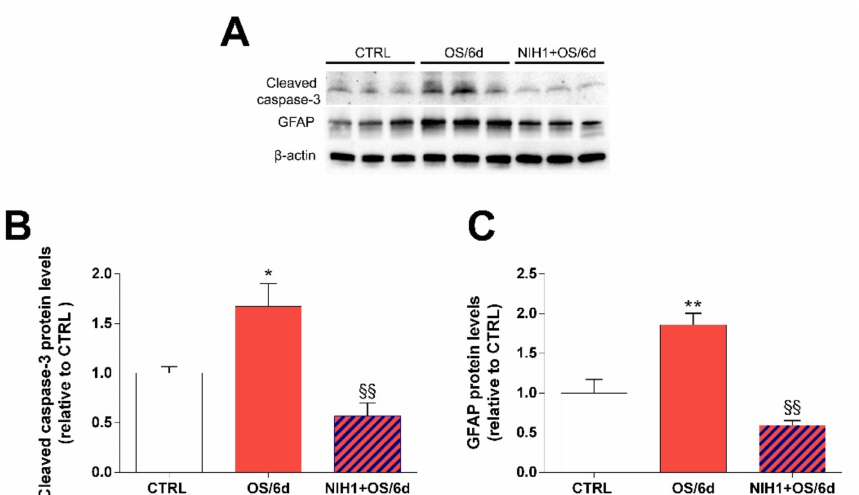
Figure 8. Effect of NIH1 on retinal cells apoptosis and glial reactivity. Western blot analysis of total protein fraction showing representative immunoreactive bands ( A ) and quantitative densitometric analysis of the cleaved caspase-3 ( B ) and GFAP ( C ) protein levels in CTRL, OS/6d and NIH1 + OS/6d explants. One-way ANOVA, n = 3; * p < 0.05, ** p < 0.01 vs. CTRL; §§ p < 0.01 vs.